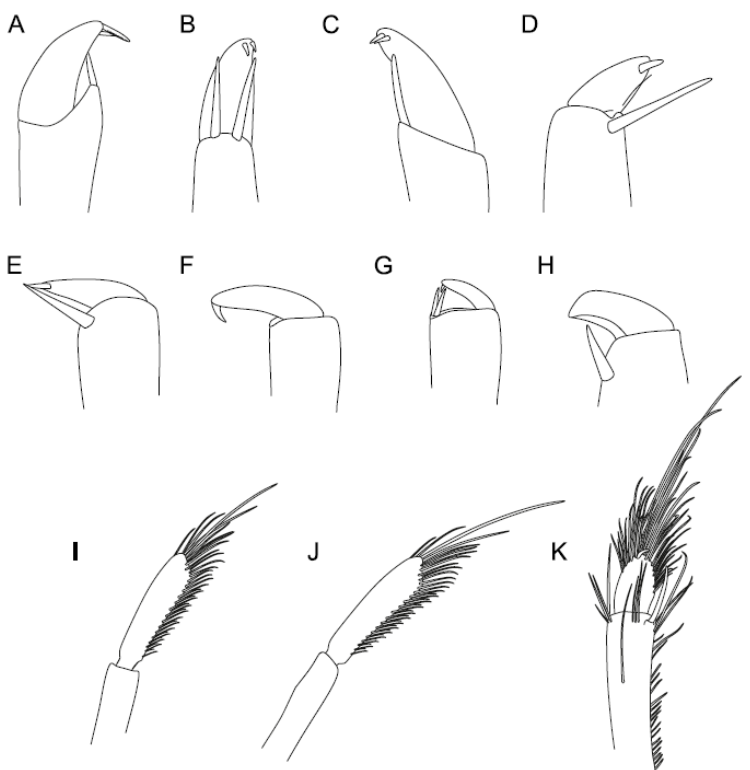
Figure 1. Terminal part of the fifth pereopod in Oplophoroidea (schematic, most non-robust setae removed): ( A )— Sclerodora crosnieri , sp. nov., ( B )— Hymenodora frontalis , side view, ( C )— Hymenodora frontalis , inner view, ( D )— Acanthephyra acutifrons , ( E )— Notostomus elegans , ( F )— Kemphyra corallina , ( G )— Meningodora longisulca , ( H )— Heterogenys microphthalma , ( I )— Systellaspis debilis , ( J )— Oplophorus gracilirostris , ( K )— Janicella spinicauda.